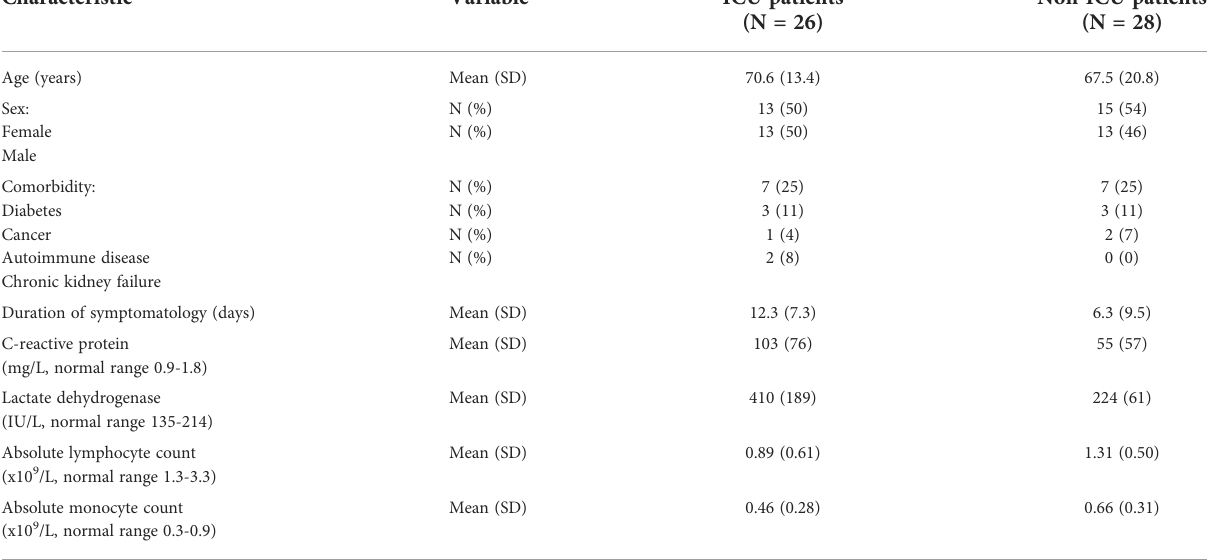
TABLE 1 Patient